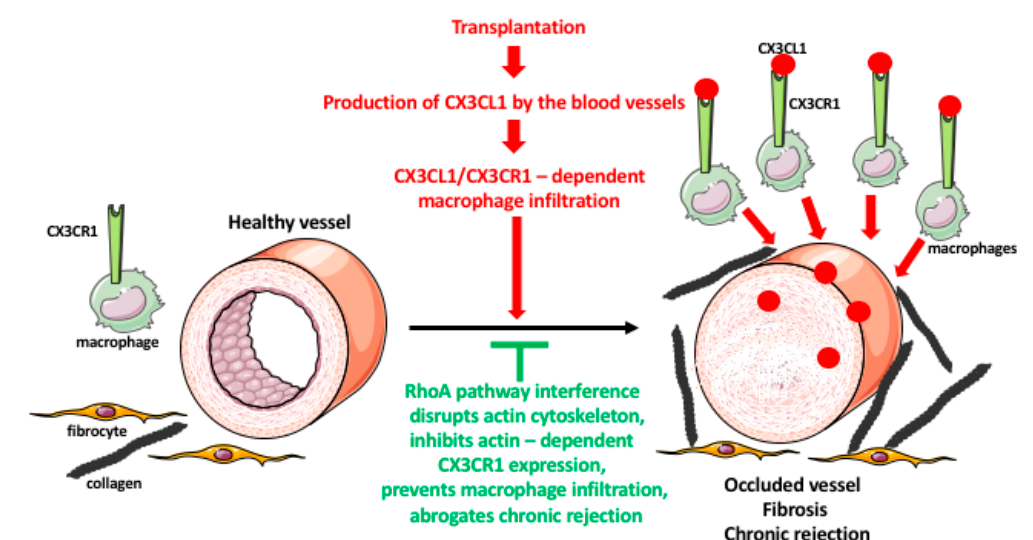
Figure 3. Role of macrophages in transplant rejection. Organ transplantation induces immune responses in the recipient. One of the responses is a massive production of the chemokine fractalkine (CX3CL1) by the endothelial cells of the graft blood vessels. The CX3CL1 recruits the monocytes / macrophages, which express the fractalkine receptor (CX3CR1), from the blood to the vicinity of the blood vessels. The macrophages induce an over-proliferation of the smooth muscle cells in the blood vessel wall, and fibroblast / fibrocyte to express a huge quantity of fibrotic factors such as collagen. These result in the occlusion of the blood vessel lumen, and graft tissue fibrosis, leading to chronic rejection of the transplant. The expression and recycling of the macrophage receptors are actin-dependent, and actin is regulated by the RhoA pathway. The interference (either RhoA deletion or pharmacologic inhibition) with the RhoA pathway disrupts the normal functioning of actin filaments and actin-dependent processes such as receptor expression and recycling. The lowered expression of CX3CR1 receptors makes macrophages less or nonresponsive to the fractalkine, prevents their infiltration into the graft, and inhibits chronic rejection.